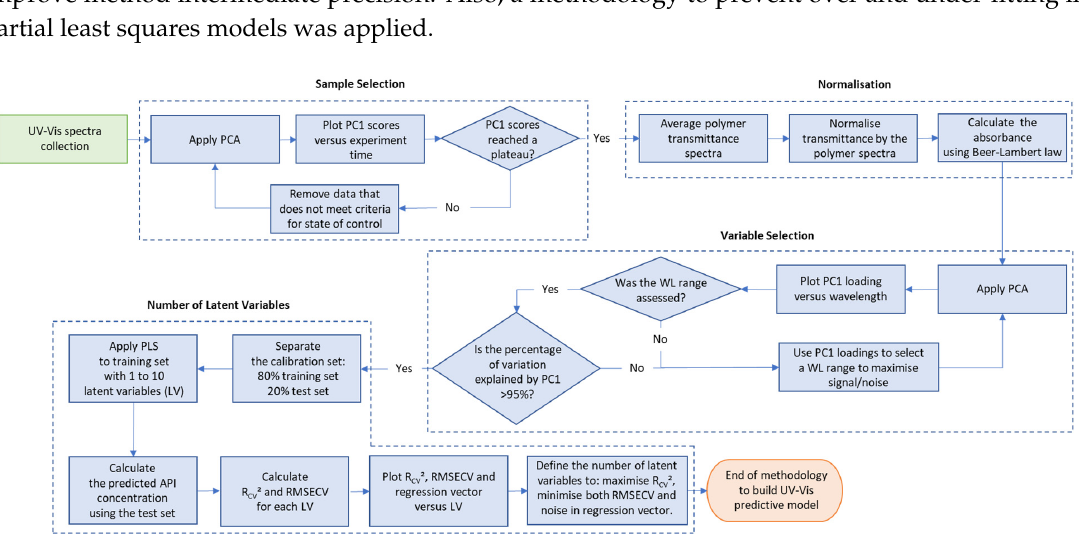
Figure 4. Methodology to build predictive model using UV-Vis spectra. WL = wavelength, PCA = principal component analysis, R cv2 = coefficient of determination, RMSECV = root mean square error, CV = cross-validation, LV = latent variables.